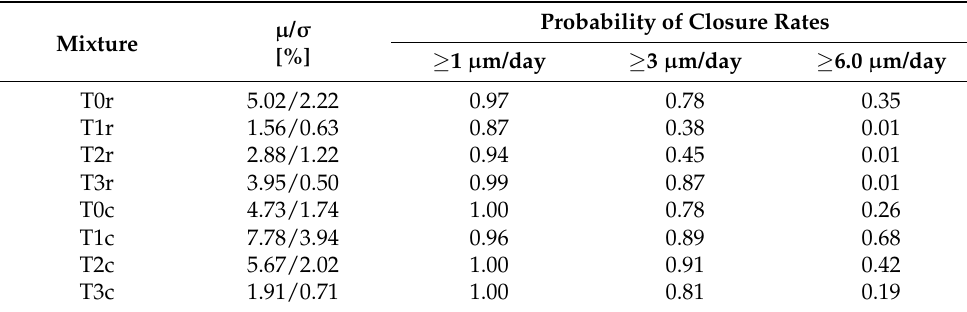
Table 6. Probabilistic parameters and probabilities of closure rates at 8 days. µ / Mixture